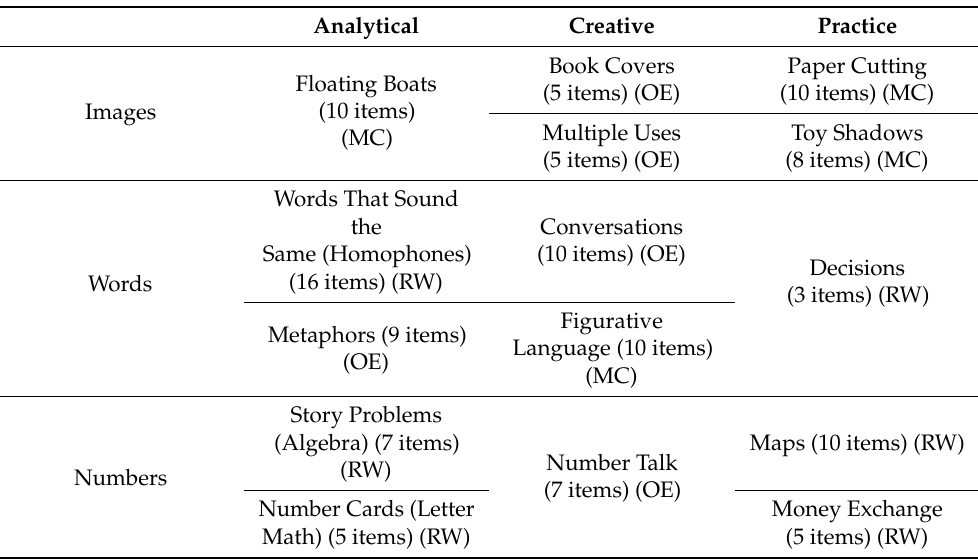
Table 2. The Chinese version of Aurora